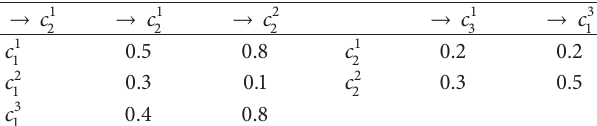
Table 2: Initial observation (𝑉,𝐹 𝑡 )